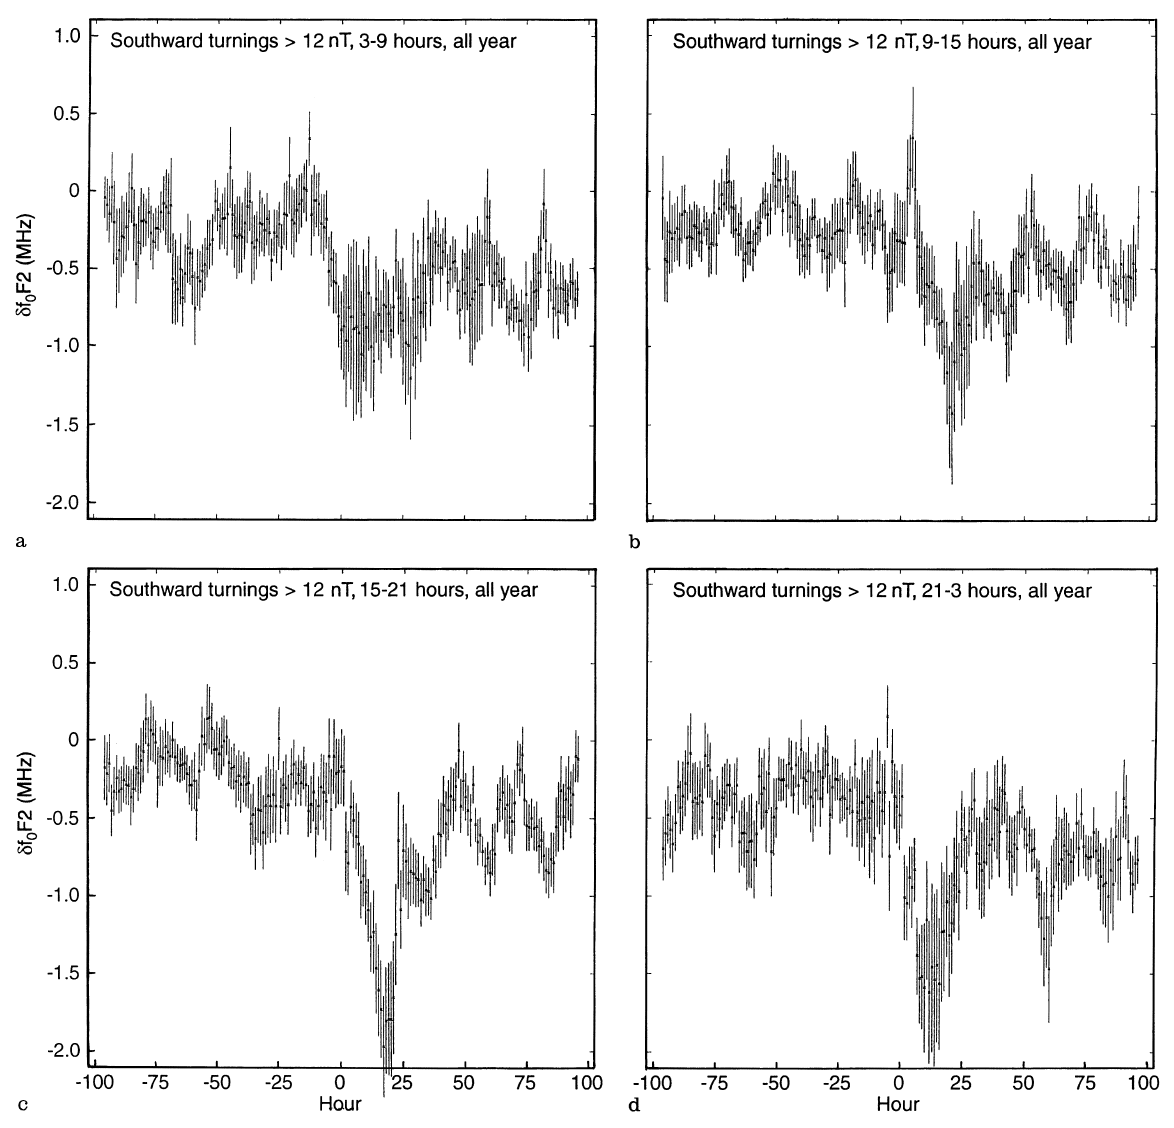
Fig. 8a–d. Same as Fig. 4(f) for southward turnings in the intervals a 03–09 UT, b 09–15 UT, c 15–21 UT and d 21–03